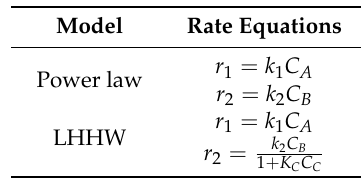
Table 9. Modeling